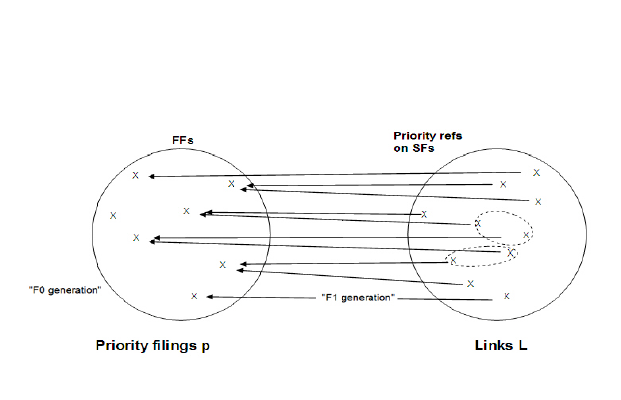
Fig. 3. Random hits